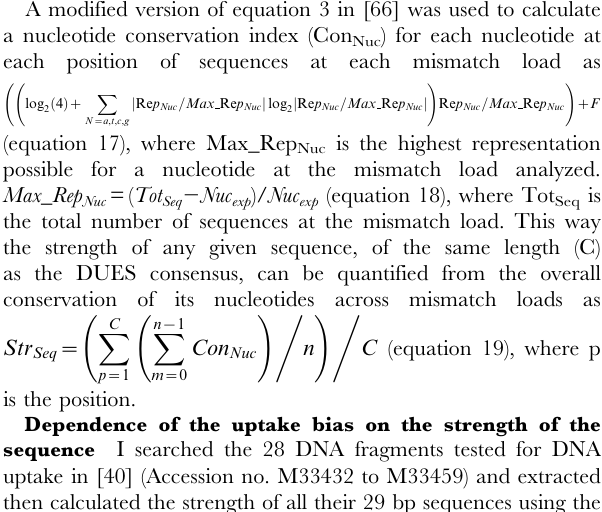
Table S1 Goodness of fit Chi-squared test ( x 2 ) on the observed and expected numbers of DUESs, control sequences, as well as all their mismatched